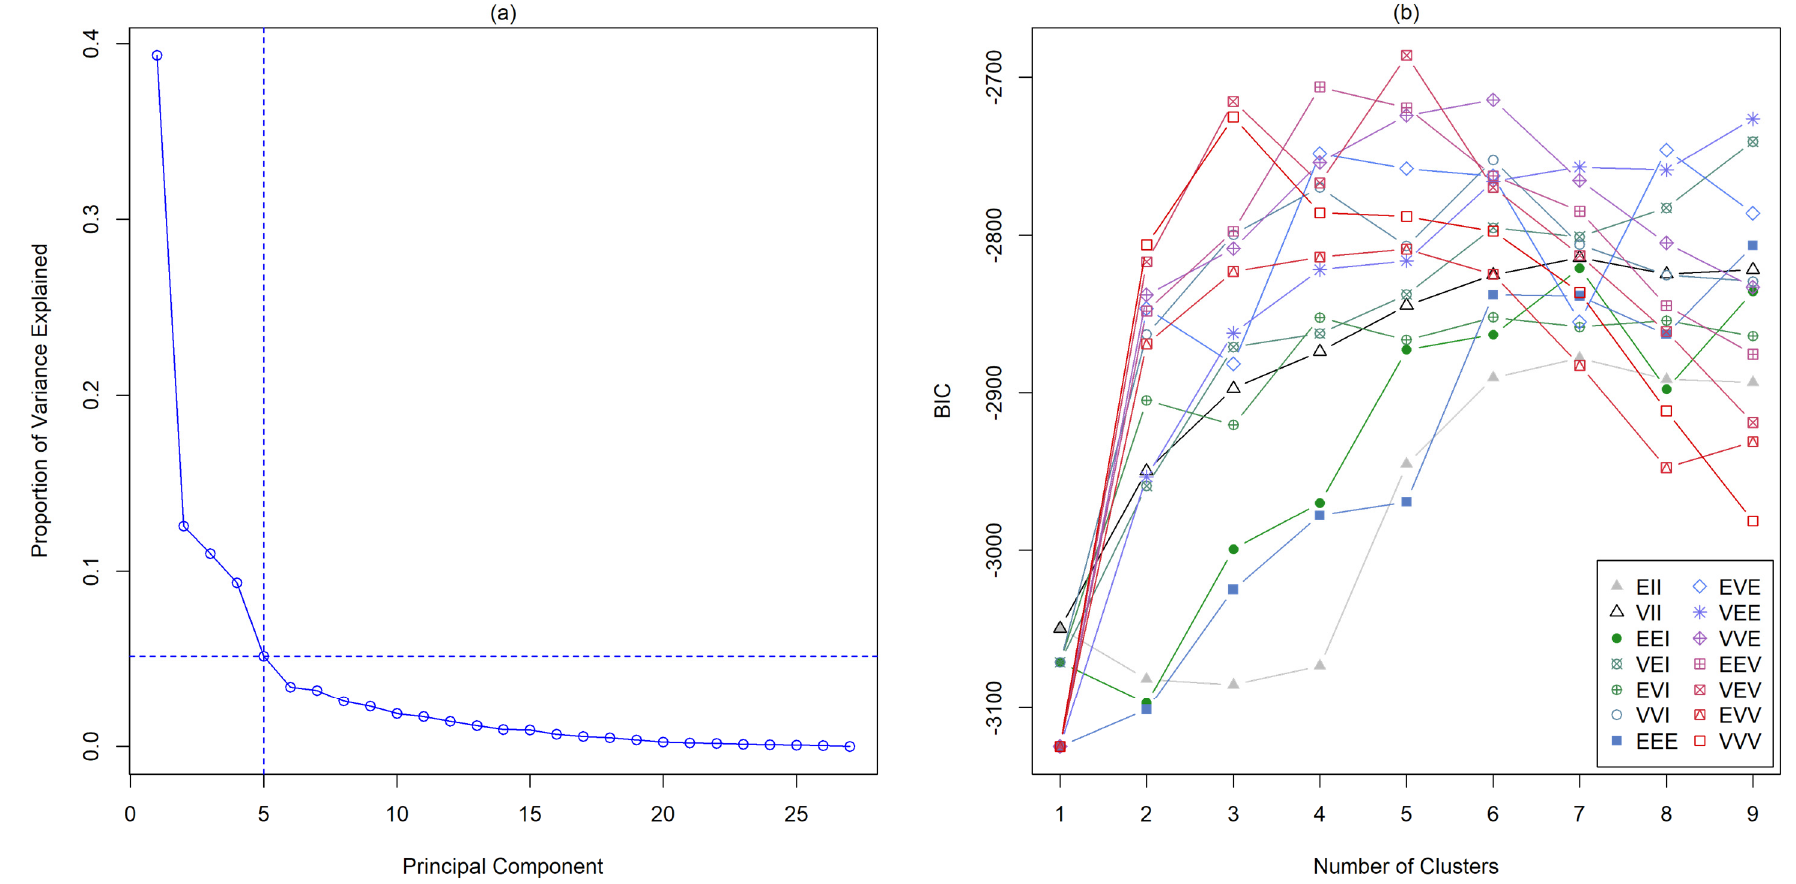
Figure A1. ( a ) Scree plot and ( b ) Bayesian information criterion (BIC) plot for Gaussian mixture model (GMM). Note: BIC defined in some literature about GMM is the negative of that defined in standard references, where smaller value of BIC is preferred. So, for GMM, a larger BIC value indicates a better model.